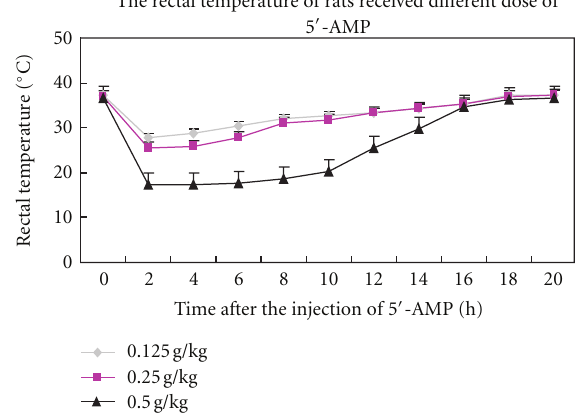
Figure 1: Construction of a rat model of hypothermia. The rectal temperature of the rats receiving di ff erent doses of 5 (cid:2)